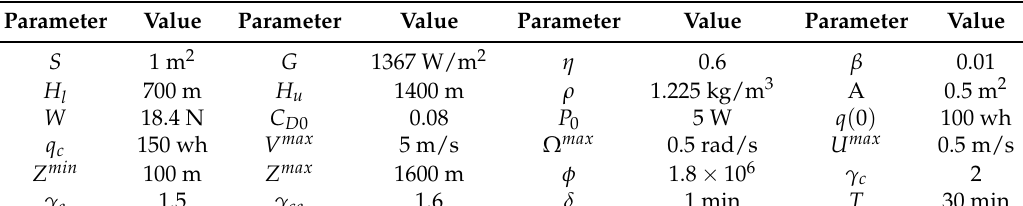
Table 2. Parameters and values.